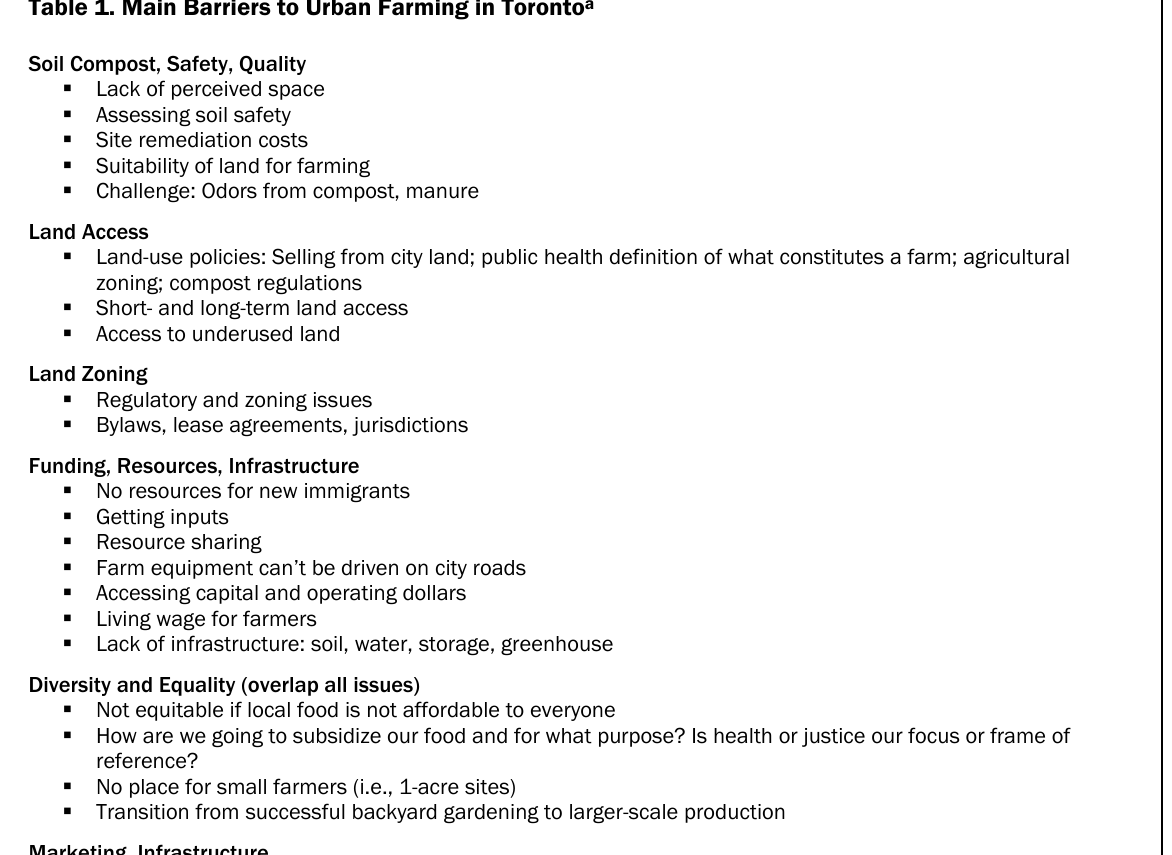
Table 1. Main Barriers to Urban Farming in Toronto